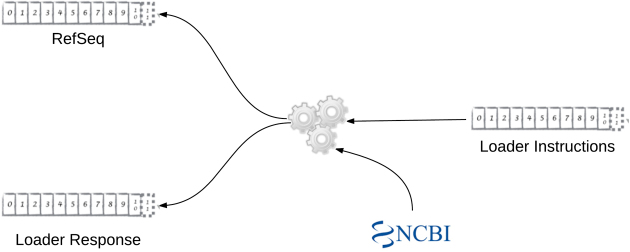
NCBI download agent.